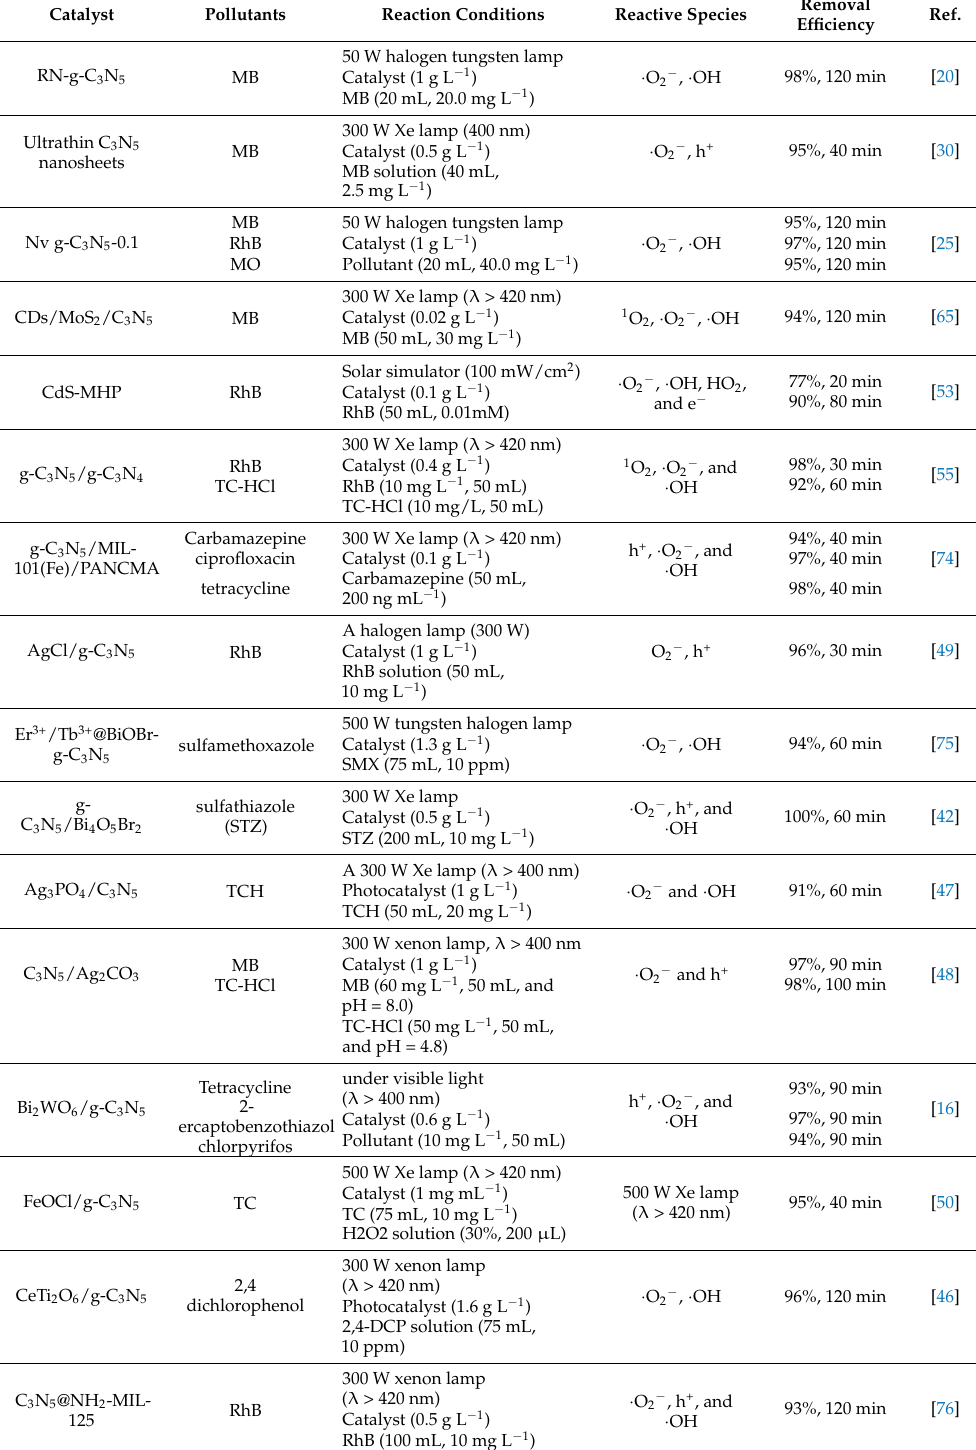
Table 3. Summary of the application of g-C 3 N 5 -based materials in degrading pollution. Catalyst Pollutants Reaction Conditions Reactive Species Removal Efficiency